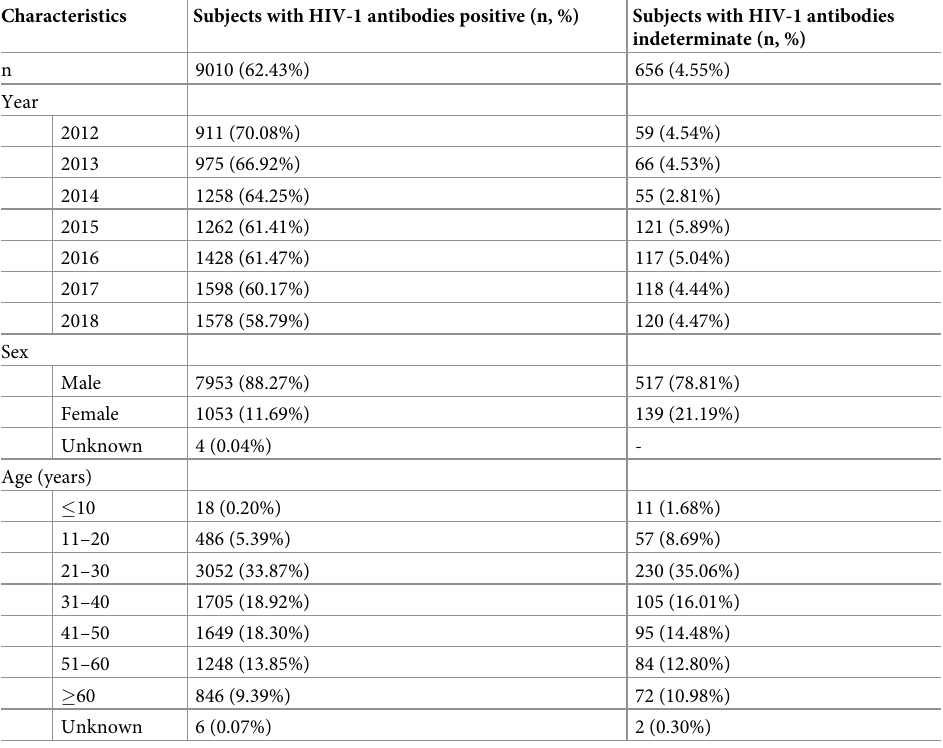
Table 1. Characteristics of subjects with HIV-1 antibodies positive or indeterminate in Wuhan, China, 2012– 2018.